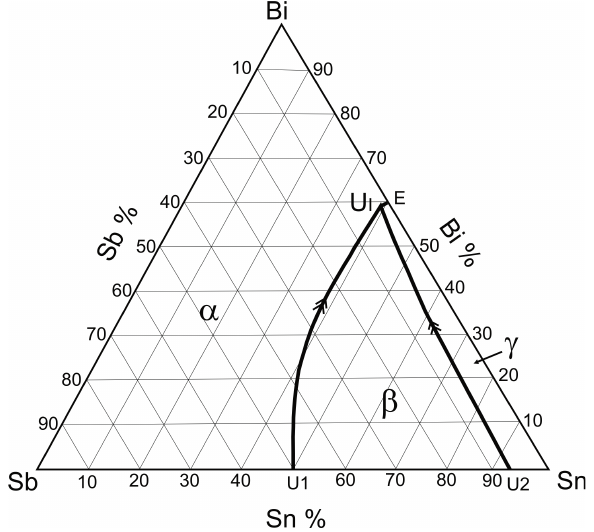
Figure 1. Liquidus surface projection